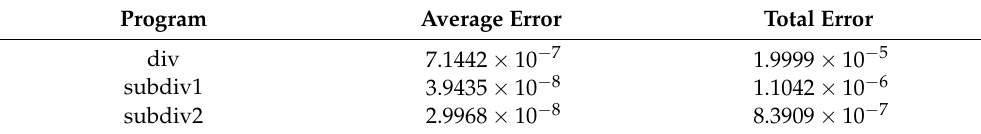
Table 2. Error comparison of quotient.